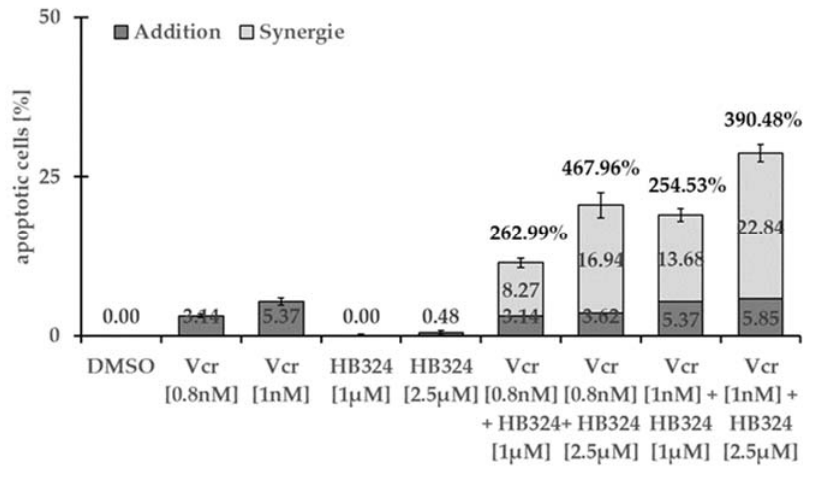
Figure 7. Nalm-6 cells were treated with 1 µ M and 2.5 µ M of HB324 and 0.8 nM and 1 nM of vincristine (Vcr) alone and in combination. Solvent treated cells (0.5% DMSO) served as the control. After 72 h of incubation, DNA fragmentation was measured by flow cytometric analysis. Values are given in percentage of apoptotic cells and as mean values ± SD (n = 3). The synergistic effect is shown as the percentages of the additional number of apoptotic cells relative to the sum of the individual number of apoptotic cells.